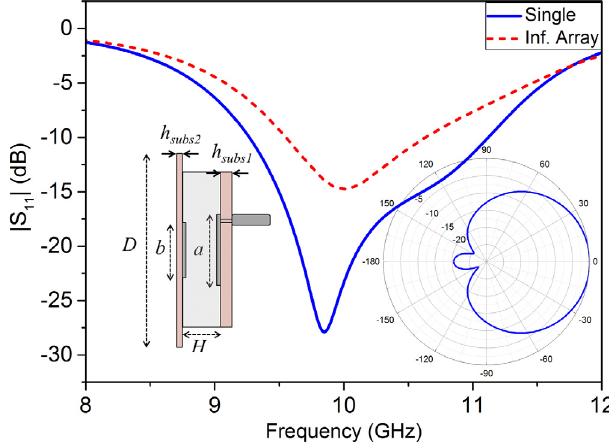
Figure 2. Simulated reflection coefficient of single element antenna. Insets: Antenna schematic and E-plane radiation pattern at 10